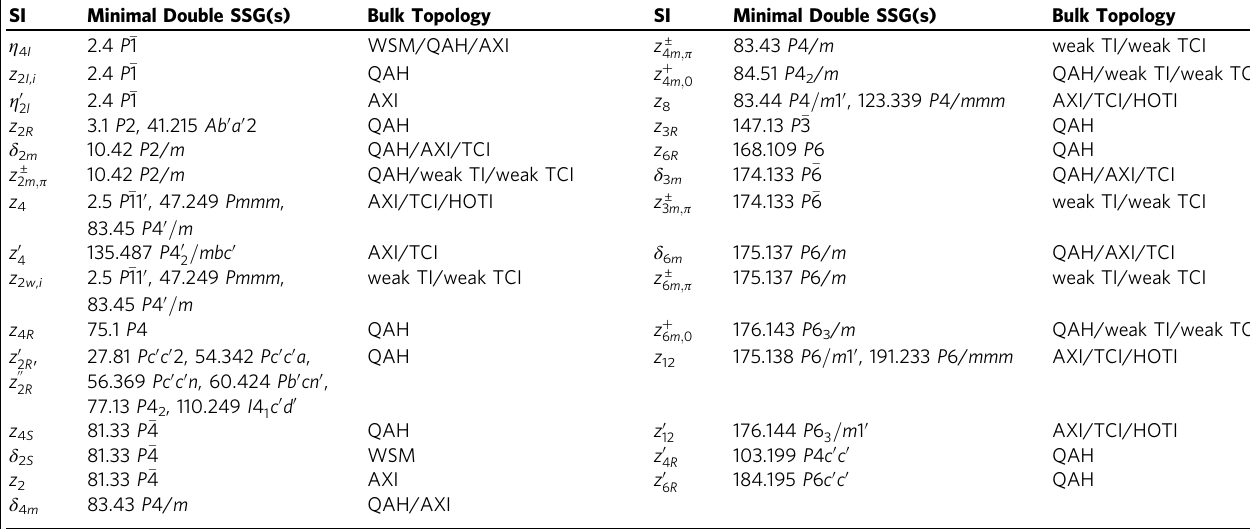
Table 2 The minimal double SIs of spinful band topology in all 1,651 double SSGs. Minimal Double SIs of Spinful Band Topology the 1,651 Magnetic and Nonmagnetic Double